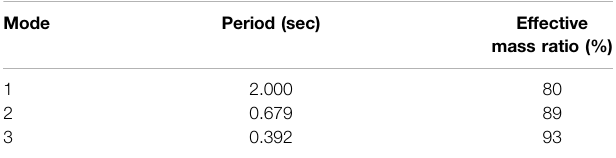
TABLE 3 | Eigen value analysis results.